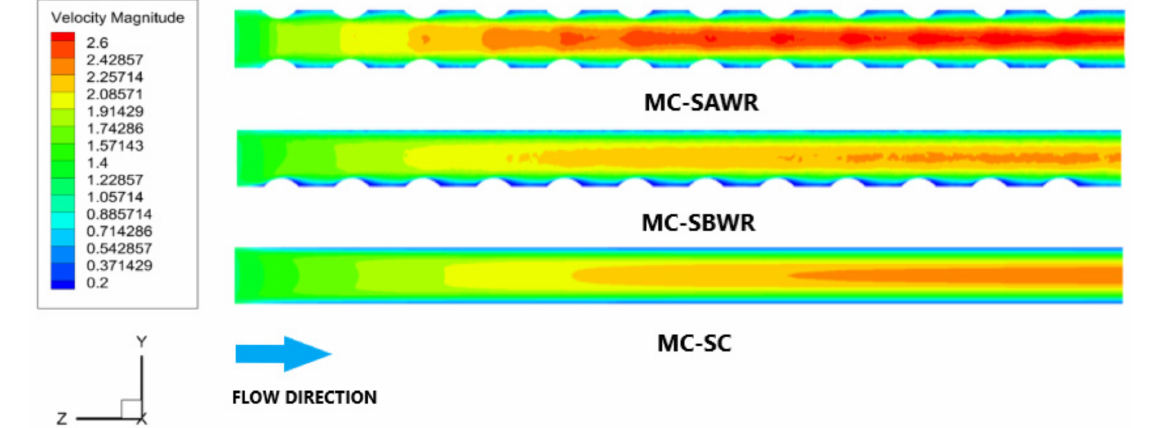
Figure 10. Velocity contours for various MCHS configurations at Re = 500 in X-Z plane at x = 0.30